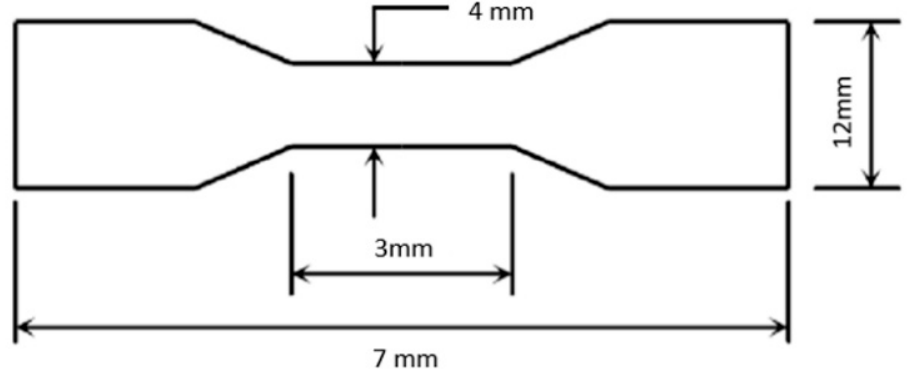
Figure 3. A schematic illustration of the sample geometry prior to testing.